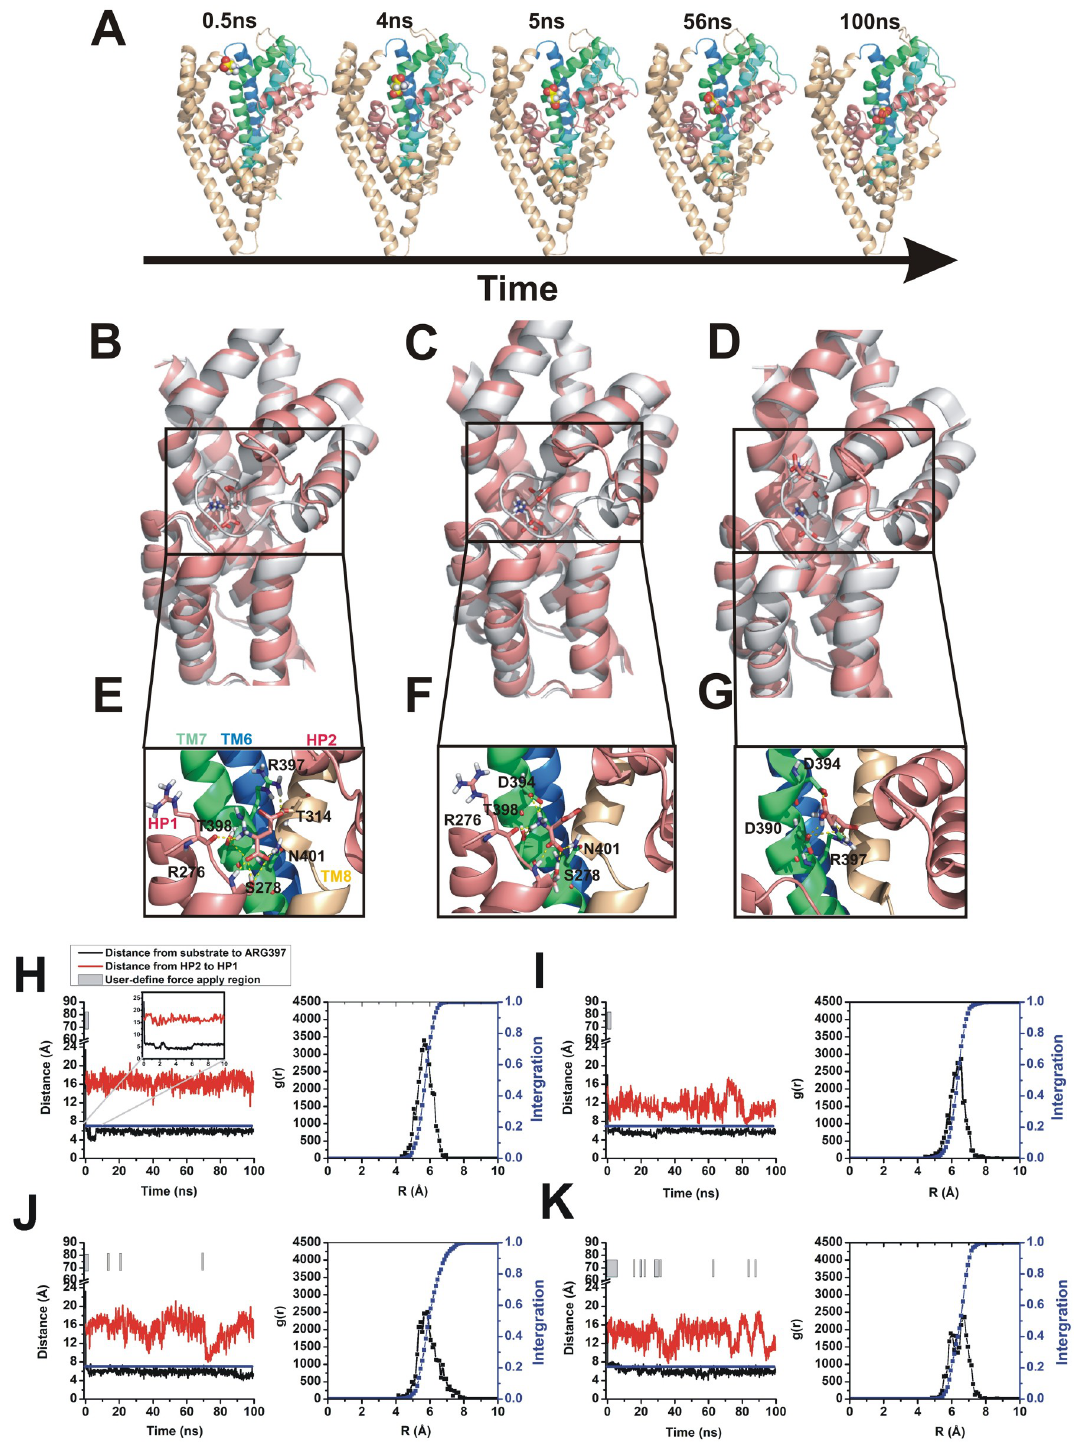
Fig 2. HP2 gate function and aspartate coordination in user-defined force simulation. (A) Substrate-protein successive binding steps. In simulations with user-defined force, within a short period of simulation time, aspartate will move close to HP2 loop, but the binding pocket is not accessible when the HP2 loop is not fully open. Once the open-gate state forms (HP2-HP1 distance larger than 12 Å ), aspartate is able to move inside the binding pocket. At this moment, the conserved residues located in TM7 stabilize the aspartate. (B-D) Coordination states with open loop from user-defined force simulation results are shown in pink. Comparison of the crystal structure (2nwx) is shown in grey. All simulation results were from sampling by adding user-defined force to conventional MD